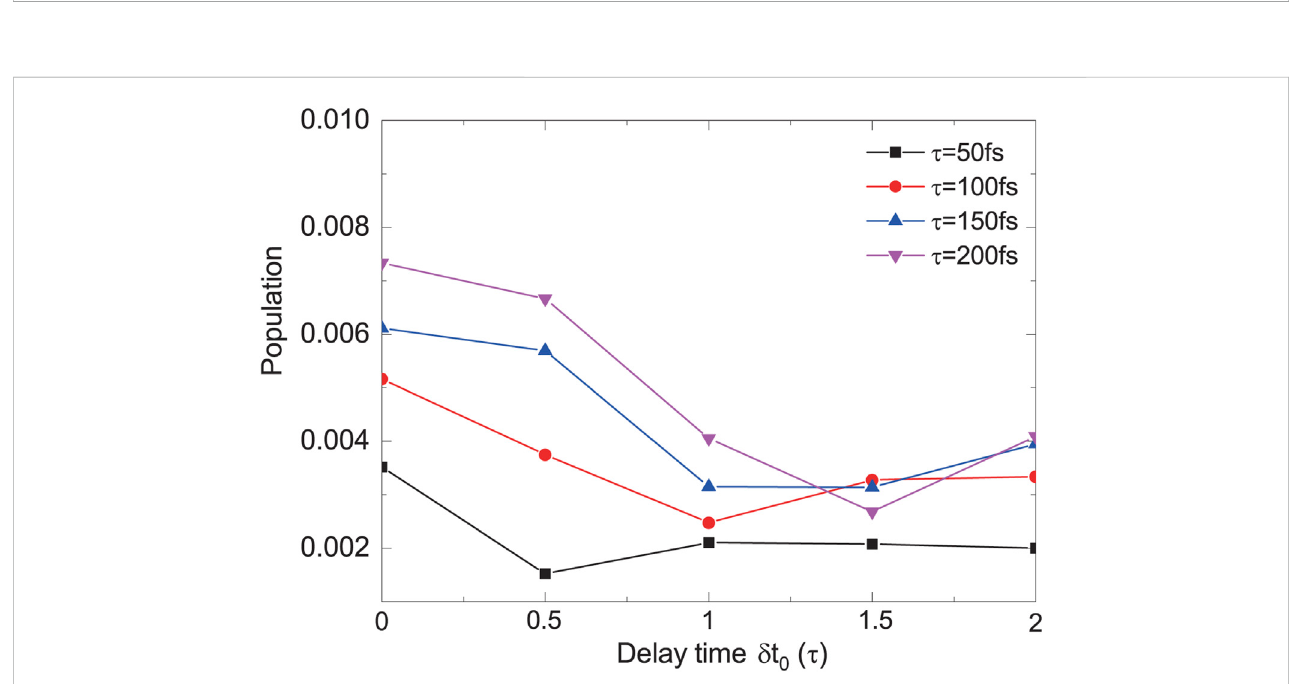
FIGURE 7 The total population of |2 〉 , |3 〉 , |4 〉 and |5 〉 as a function of the delay time in Case 3 for τ = 50, 100, 150, and 200 fs.